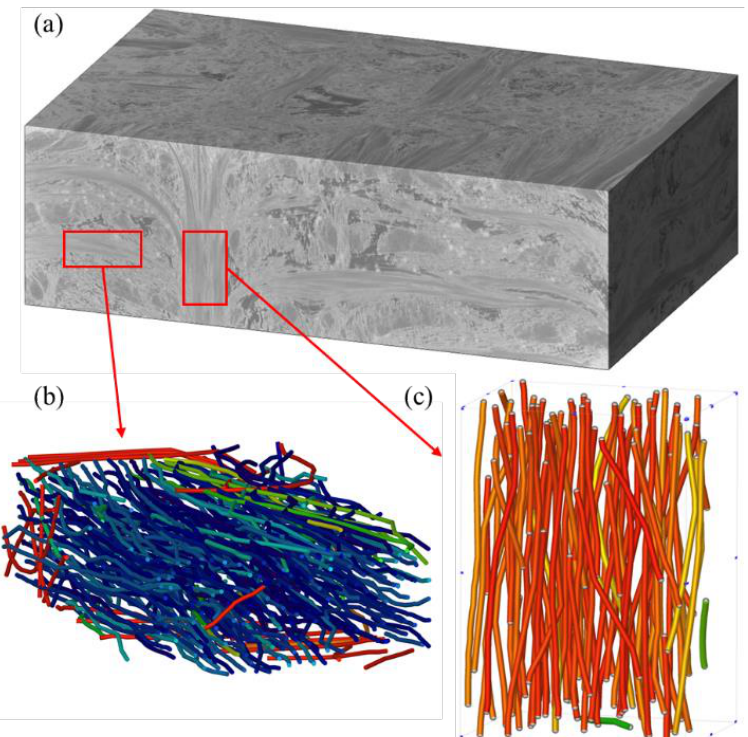
Figure 3. ( a ) μCT image ( b ) fiber distribution of unidirectional fibers and ( c ) needling fibers. In the x − y plane, the model is divided into 72 × 72 = 5184 subcells by considering the computational efficiency and the fineness of GMC geometry division, as shown in Figure 2c,d. N 0 α = N 90 α = N S α = 72, N 0 β = N 90 β = N S β = 72, where the subscripts 0, 90, and S indicate 0 ◦ weftless plies, 90 ◦ weftless plies, and short-cut fiber plies, respectively. Due to the uniform random distribution of fibers, the short-cut fiber layers are assumed to be isotropic [7,38,39]. After the SEM observation of the thickness in each layer, N 0 γ = N 90 γ = 4 and N S γ = 1 are